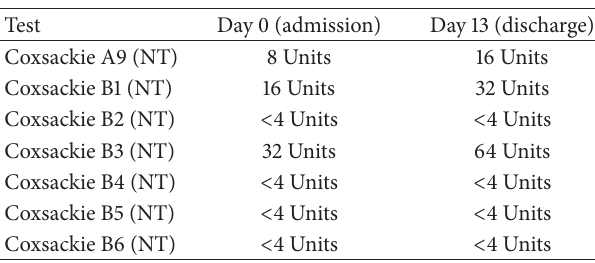
Figure 2: Abdominal computed tomography (CT) scan taken 24 h after admission. The image shows a mild enlargement of the pancreas and a diffuse inflammation of the peripancreatic tissues ( ⇒ ); however, there was no exudate. There was no pancreatic necrosis. The CT severity index is 2. Table 2: Variations in the levels of antibodies against Coxsackie viruses A9, B1, B2, B3, B4, B5, and B6 on the day of admission and at discharge (day